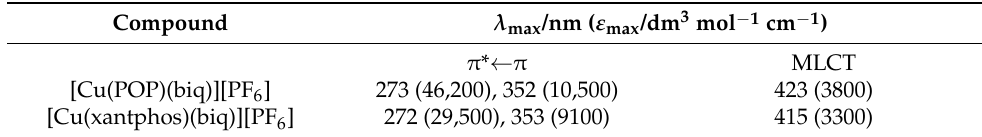
Table 2. Absorption maxima for CH 2 Cl 2 solutions of [Cu(POP)(biq)][PF 6 ] and [Cu(xantphos)(biq)][PF 6